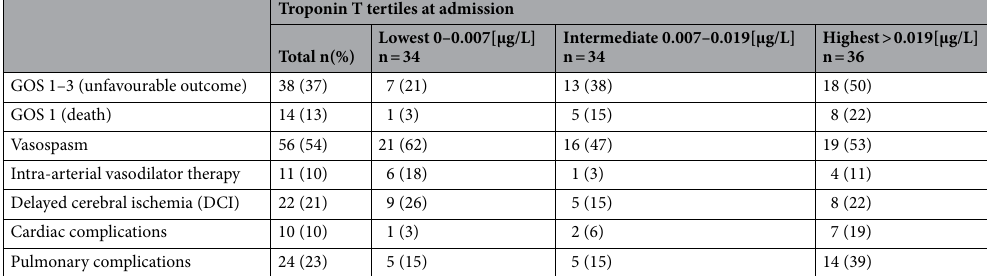
Table 2. Complications after SAH stratified by Troponin T tertiles at admission. GOS Glasgow Outcome Scale.